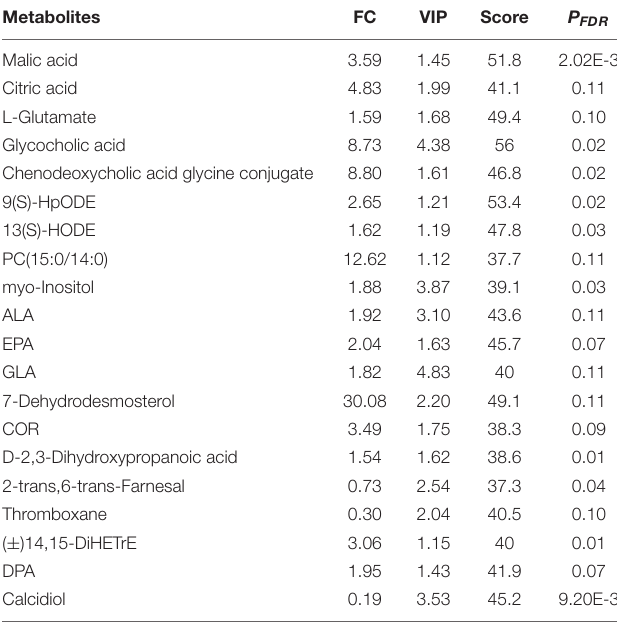
TABLE 4 | Important differential metabolites (DMs) involved in fat metabolism in FY and MY subcutaneous fat. Metabolites FC VIP